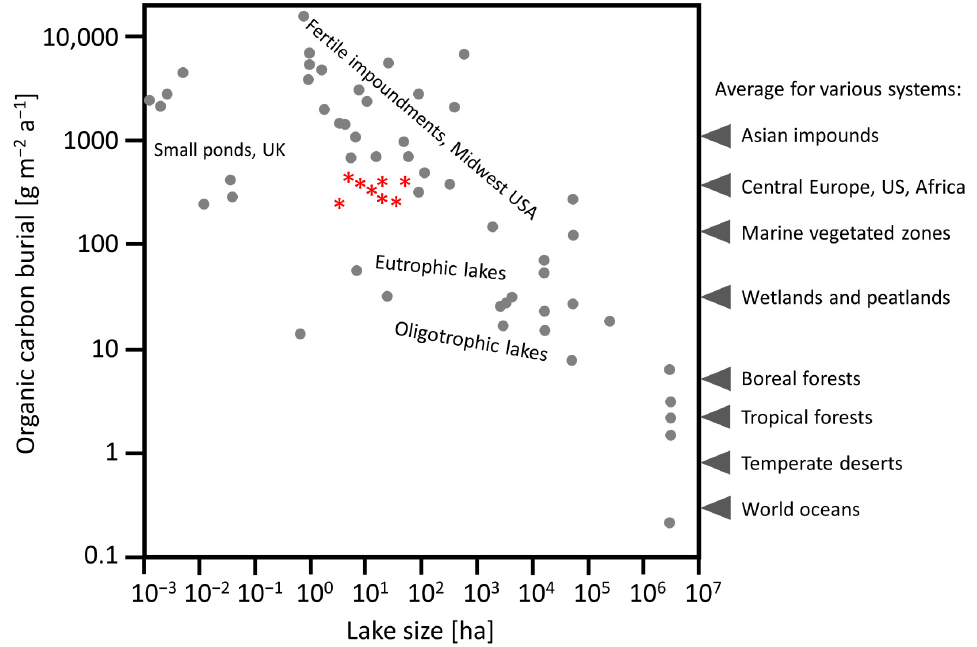
Figure 4. Accumulation of organic carbon in the studied lakes (marked with red asterisks) compared to values observed in various ecosystems (grey circles); comparative data and graph pattern according to Downing [9], modified.